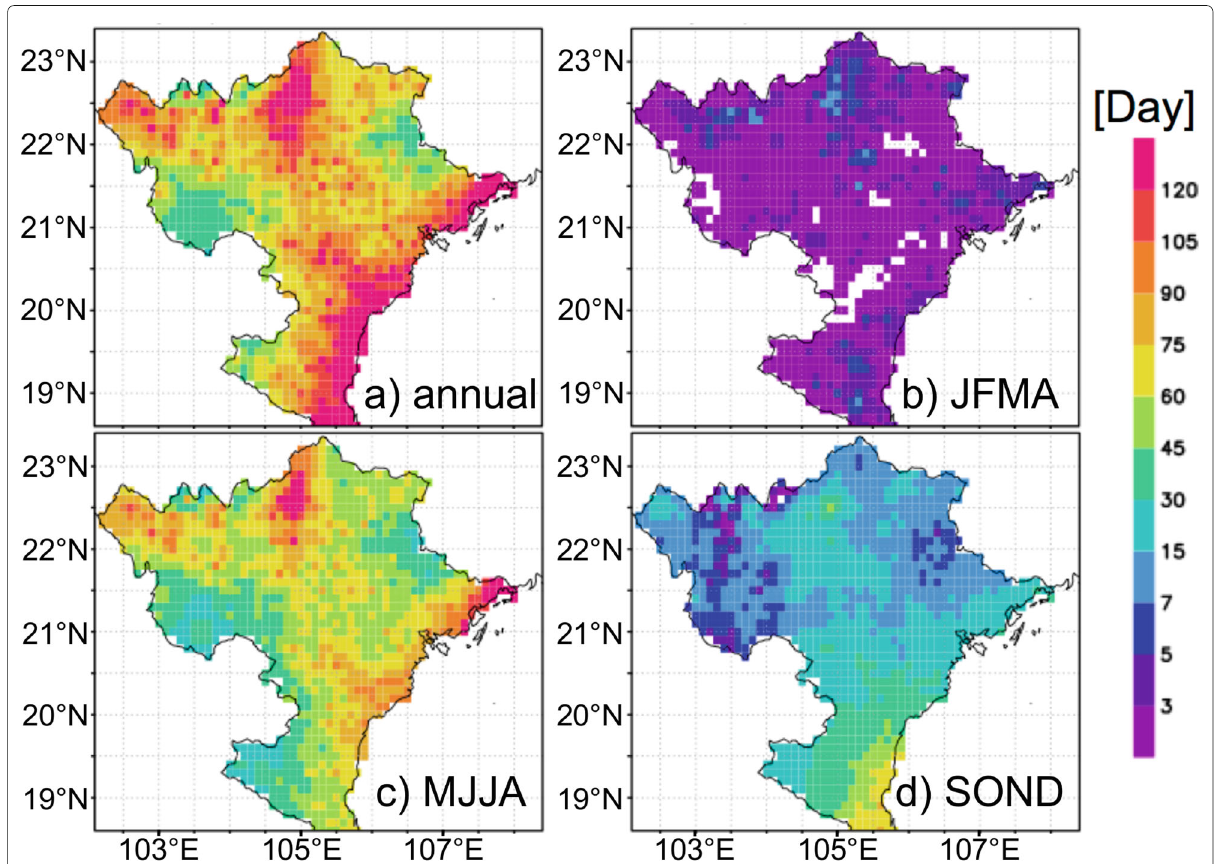
Fig. 2 The numbers of heavy-rain days (defined as a day with precipitation exceeding 50 mm day − 1 , based on VnGP data). The panels show a all months, b Jan.–Apr., c May–Aug., and d Sept.–Dec., for